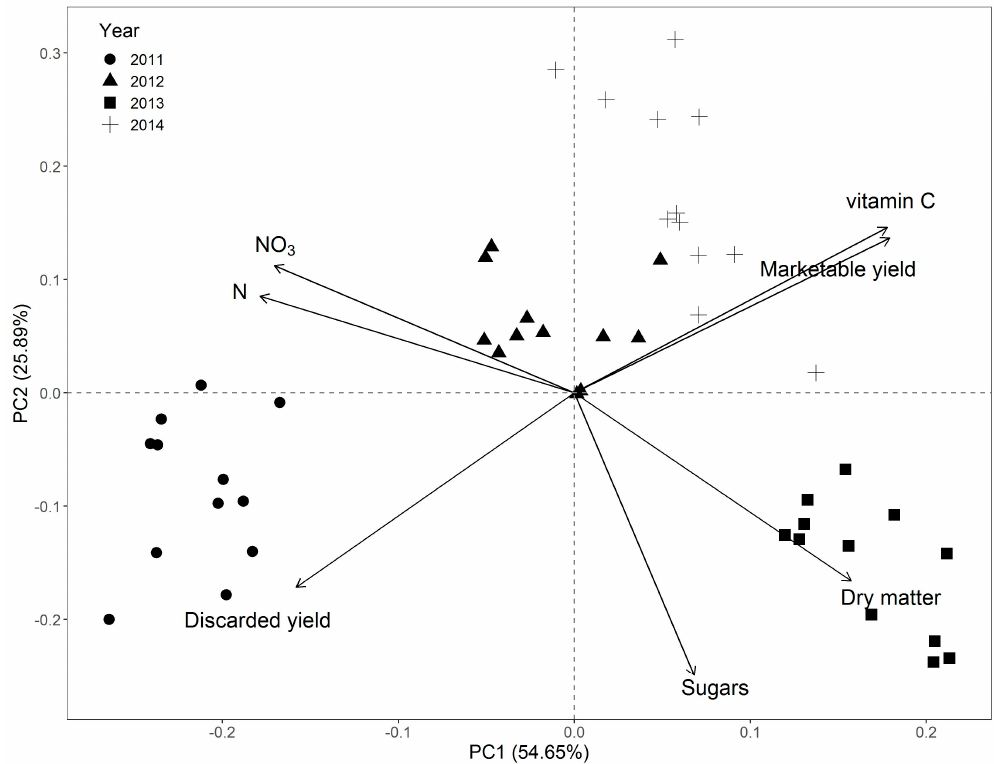
Figure 2. Biplot of principal component analysis by year. Vectors indicate the direction of increase of the carrot yield and quality parameters respective to the first two principal components; symbols distinguished by year mark the location of single samples in the PC1-PC2-plane.